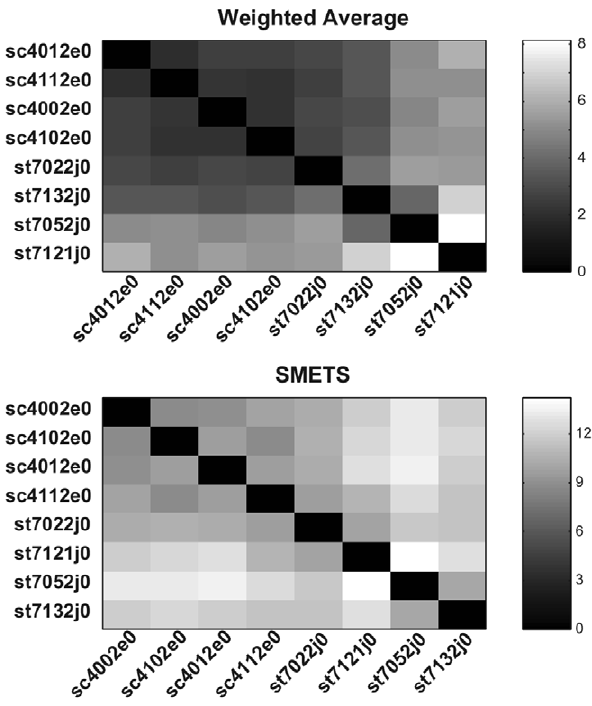
Figure 12. Distance matrices modified electrophysiological sleep data. Distance values were measured using the average and SMETS distances and are encoded in grayscale. Here all time series contain 5 dimensions (see Results section for